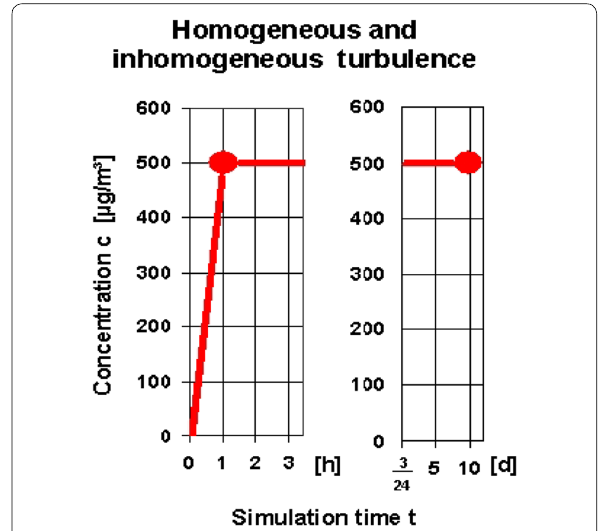
Fig. 9 The task of the AUSTAL authors trivially describes the filling of containers for all four case